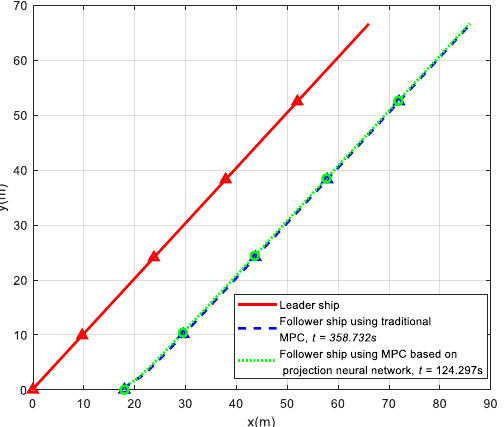
Figure 14. The comparative tracking performance on simulation time.